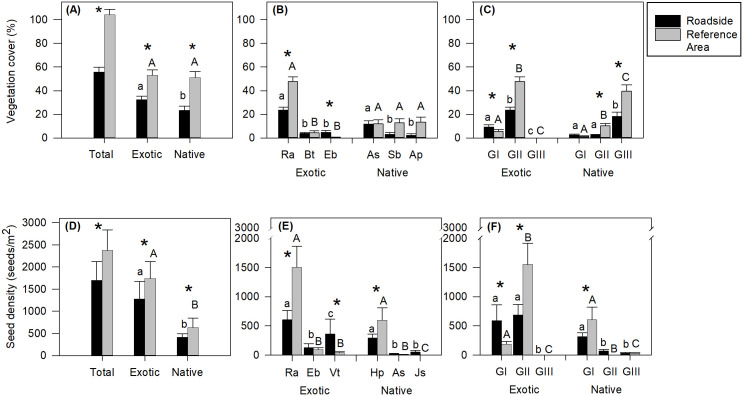
Vegetation cover, density of seeds in the seed bank and functional groups in the roadsides and references areas.Mean vegetation cover ± SE at roadsides and reference areas of: (A) total, exotic and native species; (B) the most abundant exotic species: Rumex acetosella (Ra), Bromus tectorum (Bt), Epilobium brachycarpum (Eb), and native species: Acaena splendens (As), Senecio bracteolatus (Sb) and Azorella prolifera (Ap); (C) functional groups (GI = annual/biannual herbs and grasses, GII = perennial herbs and grasses, GIII = perennial shrubs). Mean seed density ± SE at roadsides and reference areas of: (D) total, exotic and native species; (E) the most abundant exotic species: R. acetosella (Ra), E. brachycarpum (Eb), Verbascum thapsus (Vt), and native species: Heliotropium paronychioides (Hp), A. splendens (As) and Juncus stipulatus (Js); (F) functional groups. *indicates significant differences between cover (total, exotic and native), seed density (total, exotic and native), vegetation cover and seed density of the most abundant species and functional groups between roadsides and reference areas (P < 0.05). Lower-case letters indicate significant differences between vegetation cover and seed density of native and exotic species, vegetation cover and seed density of the most abundant species and functional groups at roadsides (P < 0.05). Capital letters represent significant differences between vegetation cover and seed density of native and exotic species, vegetation cover and seed density of the most abundant species and functional groups at reference areas (P < 0.05).